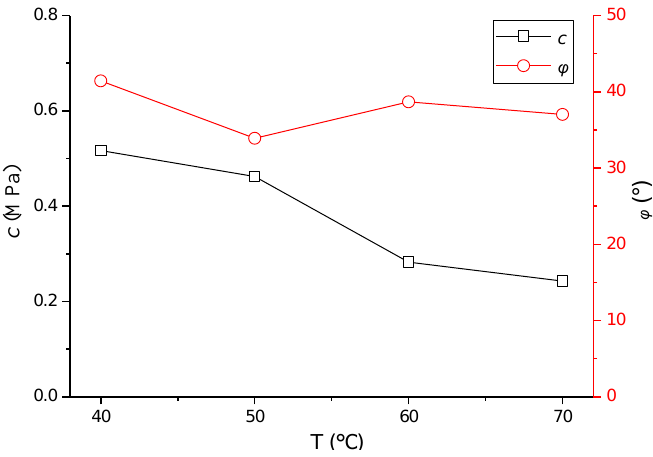
Figure 6. Effect of temperature on shear parameters.